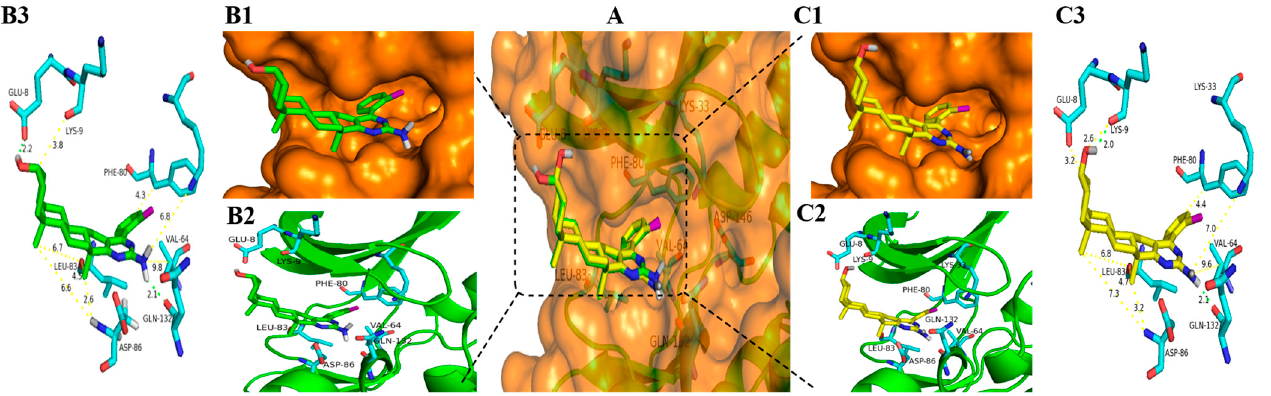
Figure 7. Docking modes of 3b and 6b with CDK1 (PDB code: 6GU6). ( A ) Overview of the binding site of 3b (green stick) and 6b (yellow stick) with CDK1 (orange transparent surface structure fused with a sticks structure of white hydrogen atoms, cyan carbon atoms, blue nitrogen atoms, red oxygen atoms, and purple chlorine atoms); ( B1 ) Position of 3b in the orange surface structure of CDK1; ( B2 ) Position of 3b in cartoon structure of CDK1; ( B3 ) Binding model for the 3b bond to CDK1 (Hydrogen bonds are drawn as green dashed lines with distances labelled in Å while the yellow dashed lines just display the distance between the atoms); ( C1 ) Position of 6b in the orange surface structure of CDK1; ( C2 ) Position of 6b in cartoon structure of CDK1; ( C3 ) Binding model for the 6b bond to CDK1 (Hydrogen bonds are drawn as green dashed lines with distances labelled in Å while the yellow dashed lines just display the distance between the atoms). Figures were drawn with Pymol (Schrödinger).